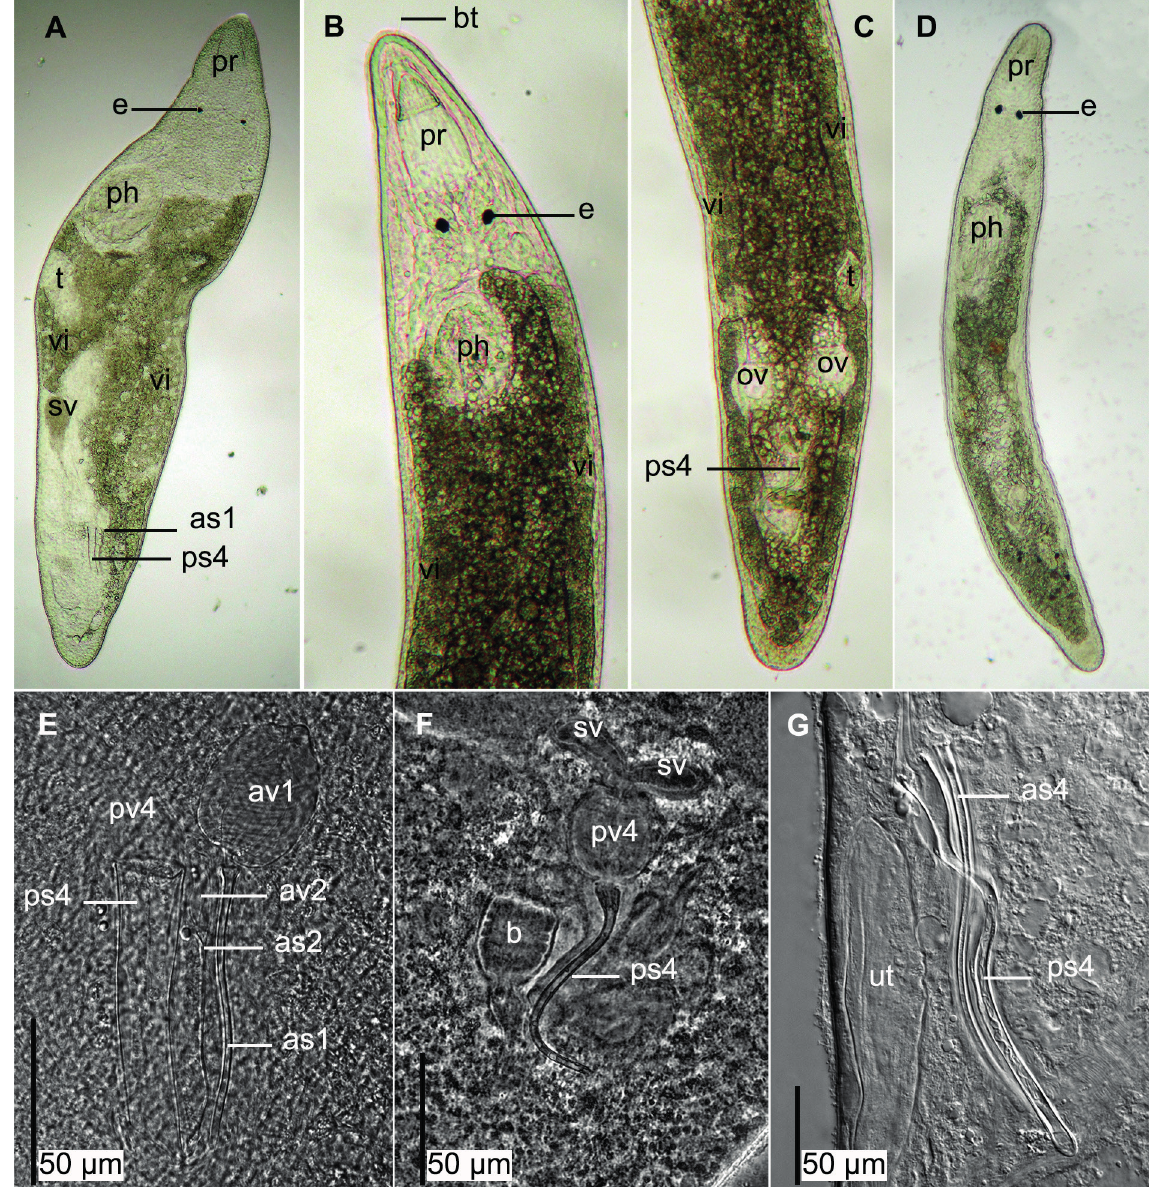
Fig. 2. New species of Phonorhynchoidinae Tessens, Janssen & Artois, 2014. A, E . Brachyrhynchoides ortizi sp. nov. B–C, F . Djeziraia adriani sp. nov. D, G . Phonorhynchoides lalanai sp. nov. A–D .